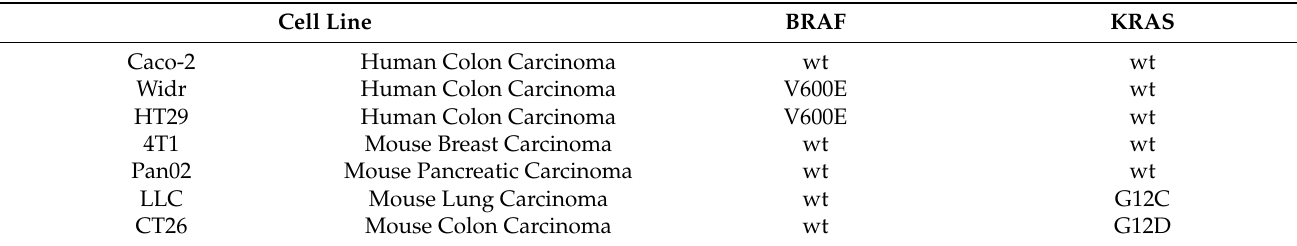
Table 1. Tumor cells with different BRAF and KRAS